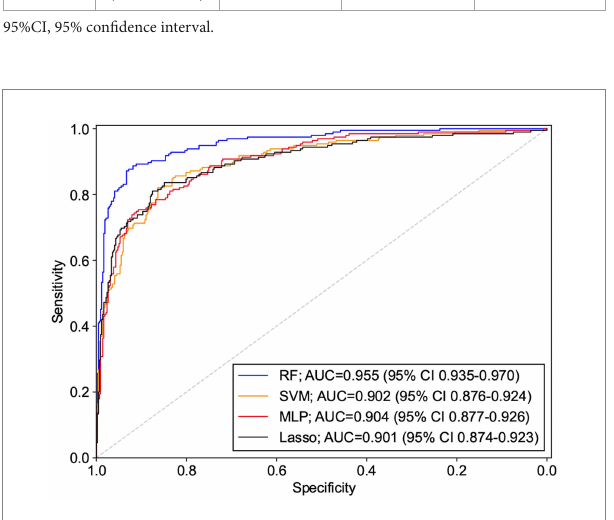
FIGURE 2 ROC and AUC values of different machine learning models on the testing set.